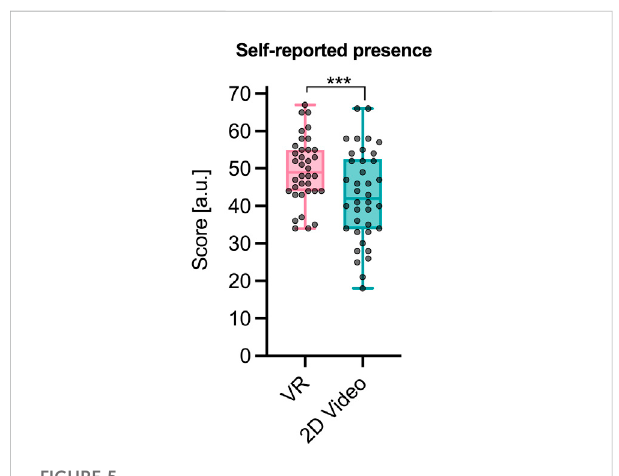
FIGURE 5 Box and whisker plot for presence scores ( y -axis represents the full range of possible scores, from 0 to 70). *** p < .001, a.u. = arbitrary